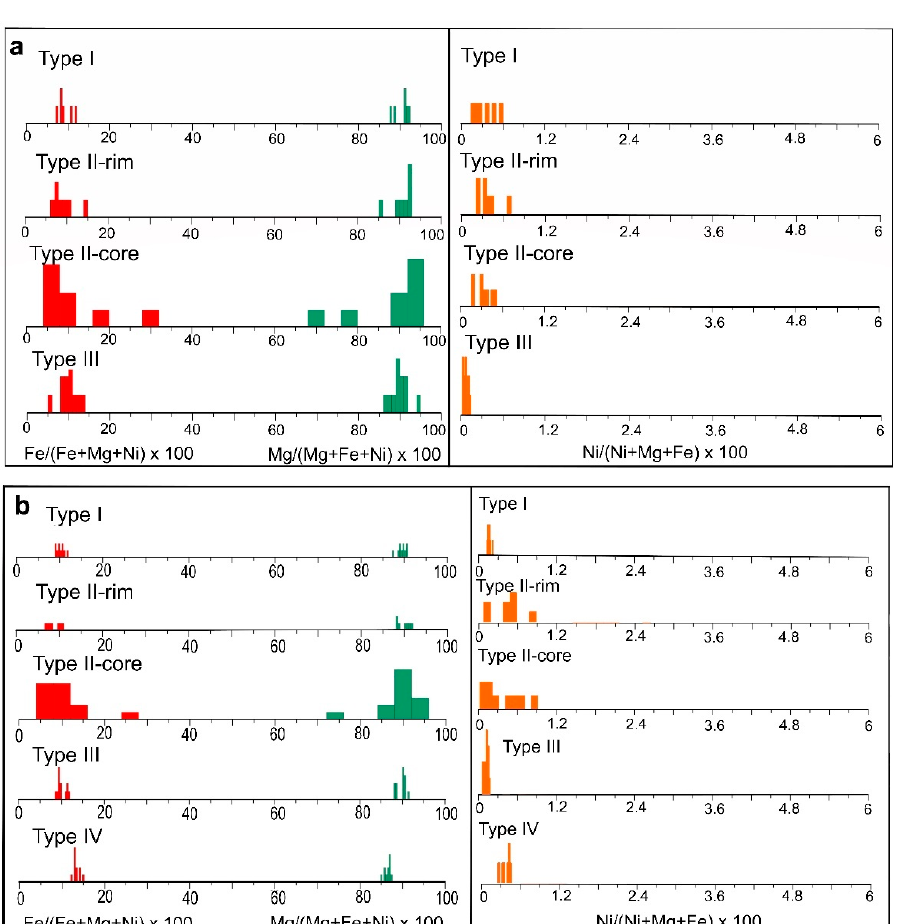
Figure 11. Histogram of Mg (green), Fe (red) and Ni (orange) mol ratio in the different types of serpentine identified in the saprock derived from ( a ) lherzolite ( b ) harzburgite-dunite and ( c ) clinopyroxenite bedrock .